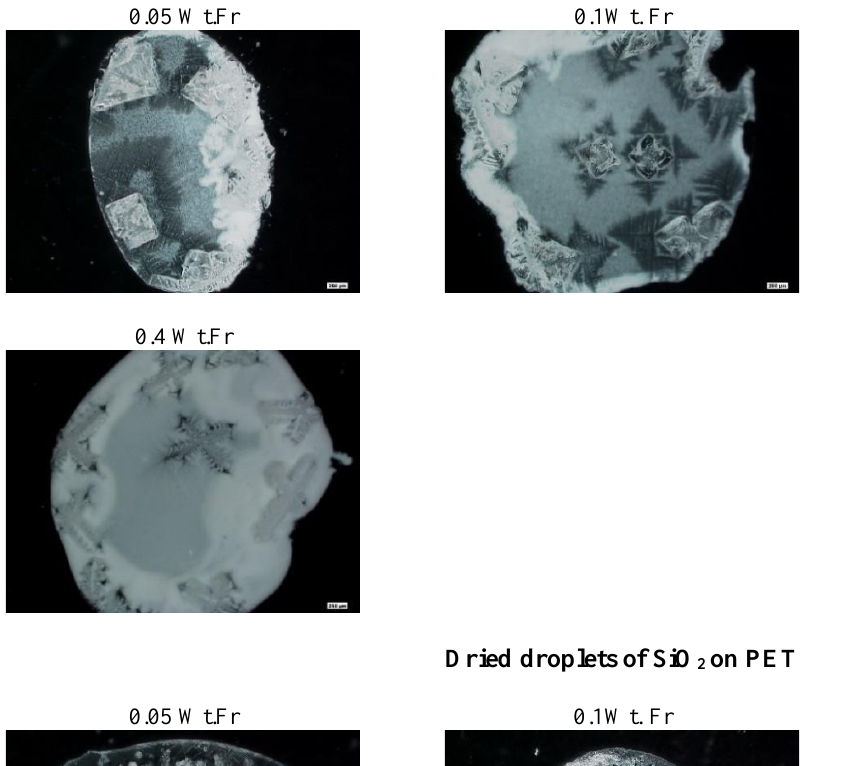
O we see large crystals. We see coffee stain behavior 2 3 but not in Al 2